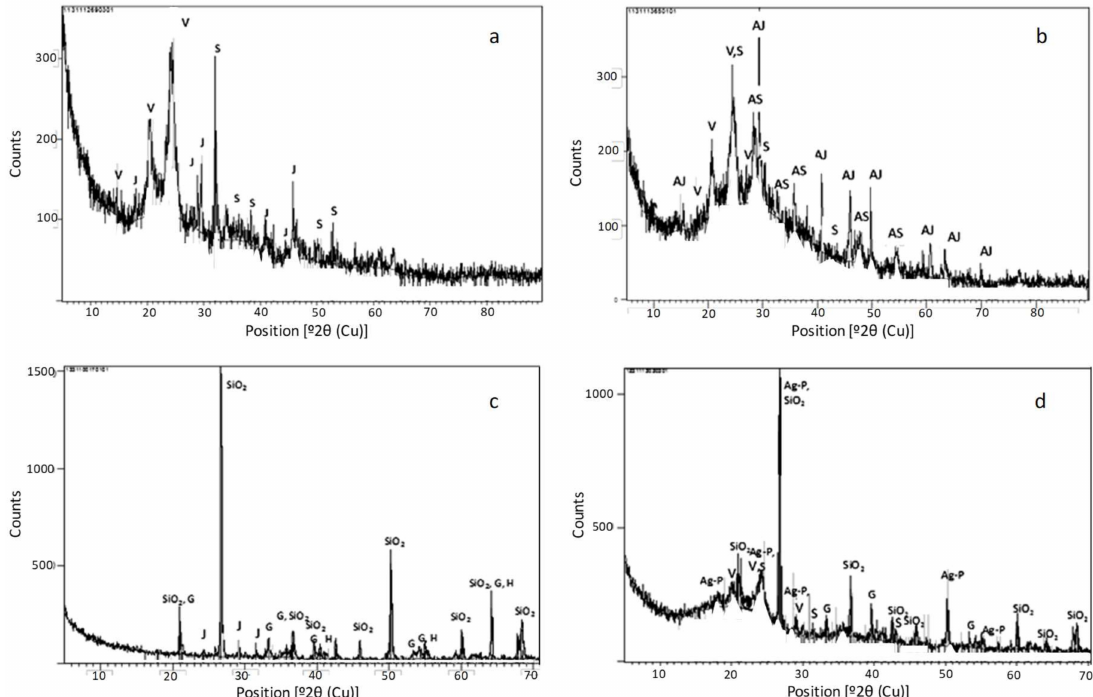
Figure 3. XRD patterns of the gossan mineral and the residues of different jarosites after microbial treatment: ( a ) Residue of K- and NH 4 -jarosites (J = jarosite; S = siderite; V = vivianite); ( b ) residue of Ag-jarosite (AJ = argentojarosite; AS = silver sulphide; S = siderite; V = vivianite); ( c ) raw gossan mineral (G = goethite; H = hematite; SiO 2 = quartz; J = jarosite); and ( d ) residue of gossan mineral (Ag-S = argentopyrite; S = siderite; V = vivianite; G =